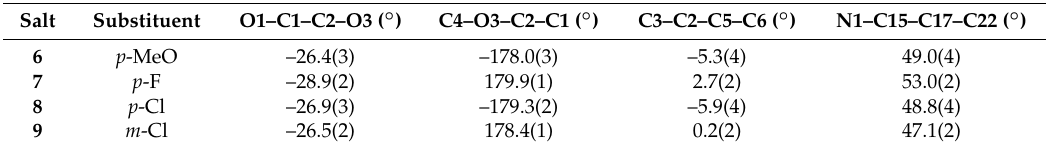
Table 2. Conformational parameters of salts 6 – 9 .